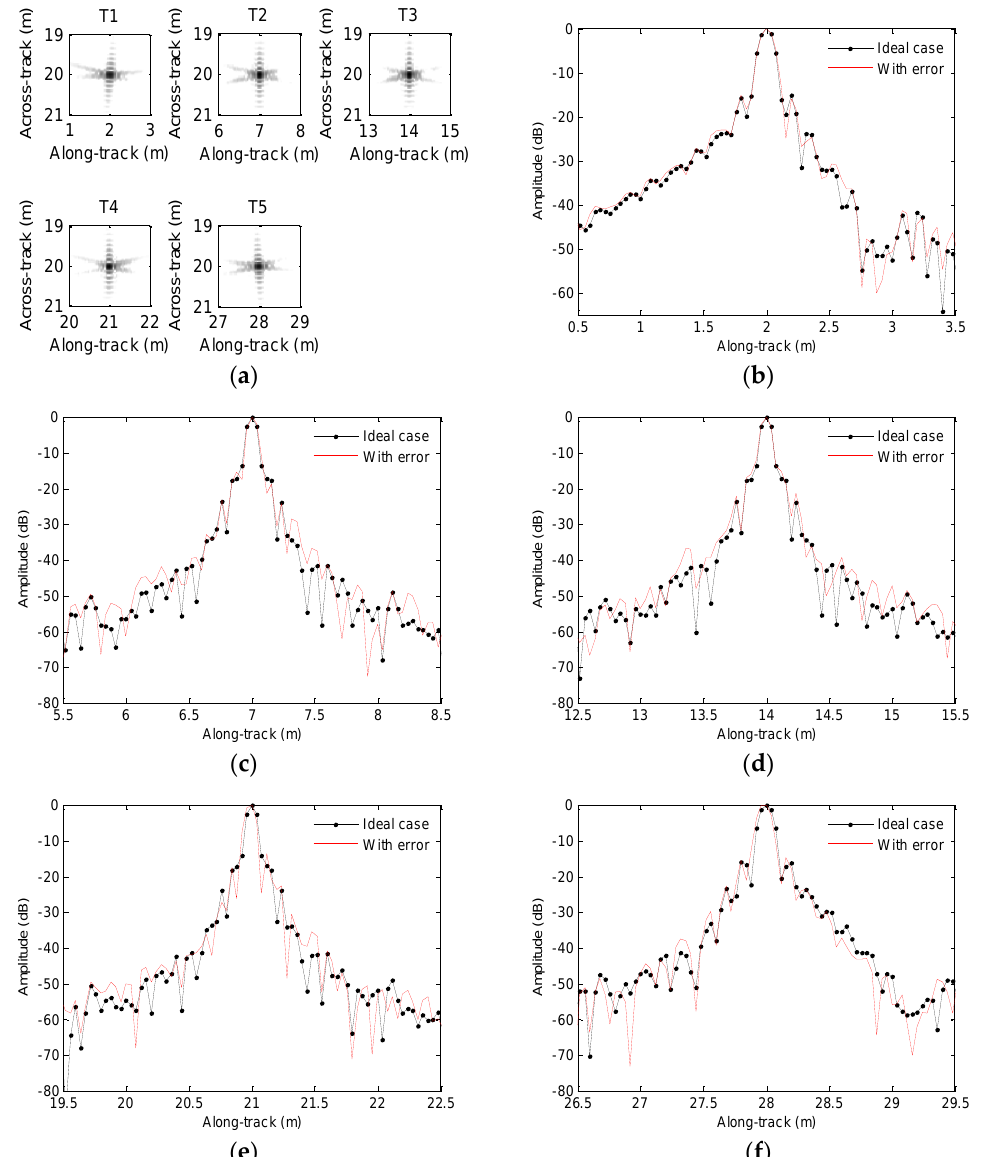
Figure 16. Processing results with surge: ( a ) imaging result; ( b ) slice of T1; ( c ) slice of T2; ( d ) slice of T3; ( e ) slice of T4; ( f ) slice of T5.